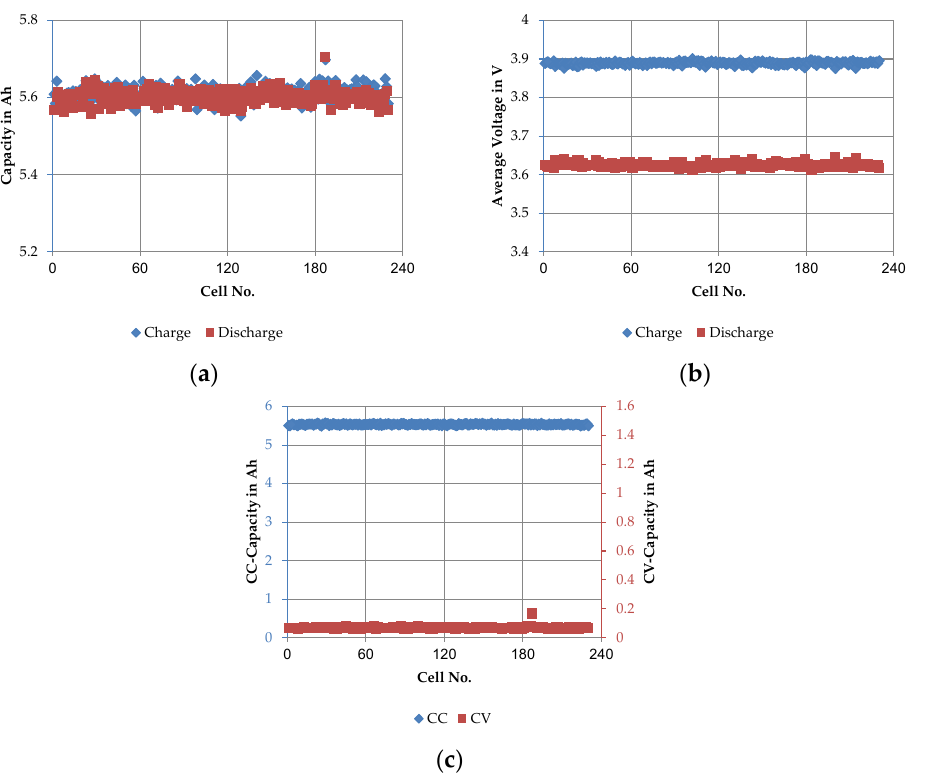
Figure 7. Main results of the regeneration phase of the long quality test: ( a ) average 1C-CCCV charge capacity vs. 1C-CCCV discharge capacity, cycle C3–C7; ( b ) average voltage of 1C charging step vs. average voltage of 1C discharging step, cycle C3–C7 and ( c ) average values of 1C-CC discharge capacity vs. average values of 1C-CV discharge capacity, cycle C3–C7.